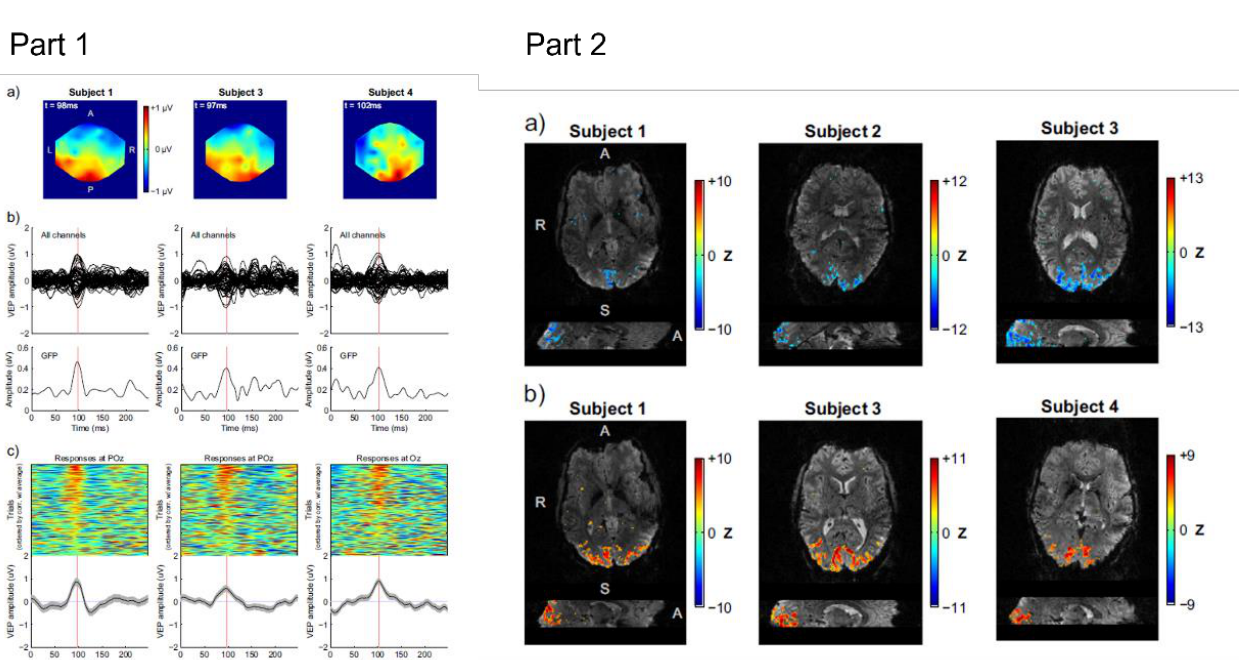
Figure 10. Part 1. Responses to reduced-field reversing checkerboard stimulation in 3 human volunteers, as captured by EEG during simultaneous EEG–fMRI acquisitions. ( a ) Scalp potential maps at the timing of the expected P100 peak. ( b ) Trial-averaged responses of all 63 EEG channels, and